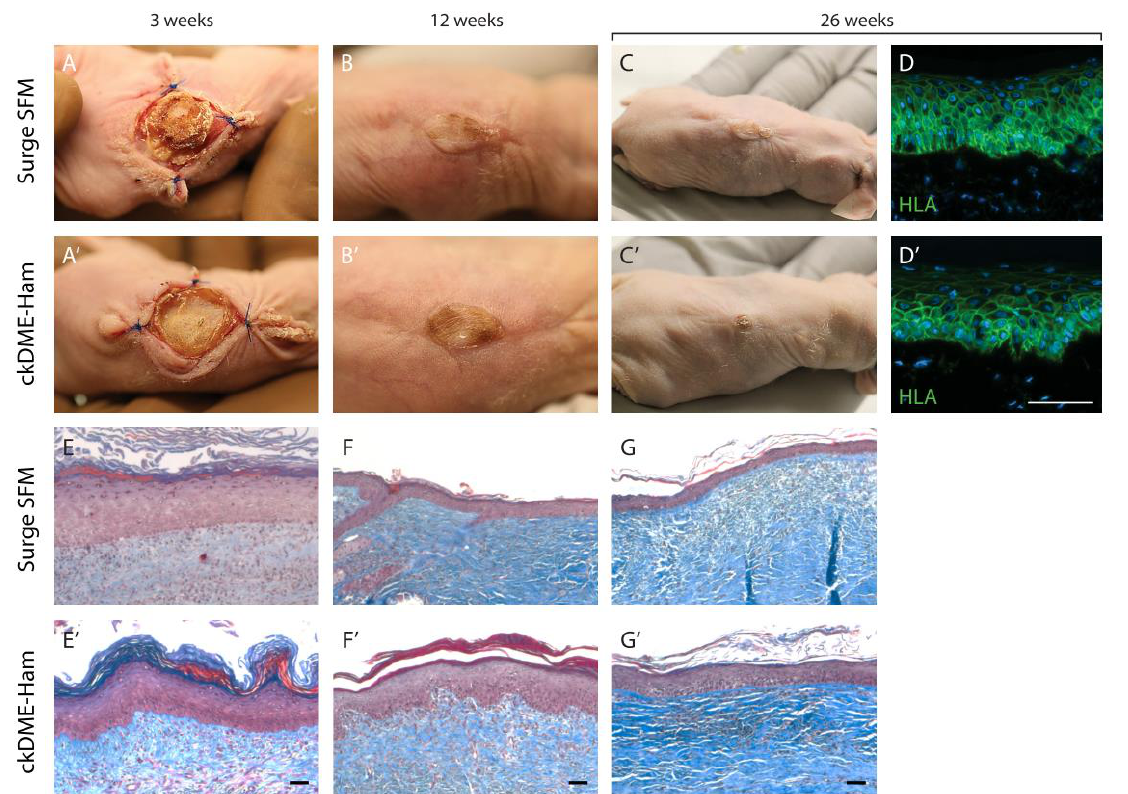
Figure 7. Functional analysis of human TESs produced with either ( A – G ) Surge SFM or ( A ’ – G’ ) ckDME-Ham. TESs were grafted on athymic mice. Macroscopic view at ( A , A’ ) three weeks, ( B , B’ ) 12 weeks, and ( C , C’ ) 26 weeks after grafting. ( D , D’ ) Immunofluorescence staining against human leucocyte antigen (HLA) 26 weeks after grafting the TESs. Cell nuclei were stained with Hoechst reagent. Masson’s trichrome staining at ( E , E’ ) three weeks, ( F , F’ ) 12 weeks, and ( G , G’ ) 26 weeks after grafting. Scale bar: 50 µm.